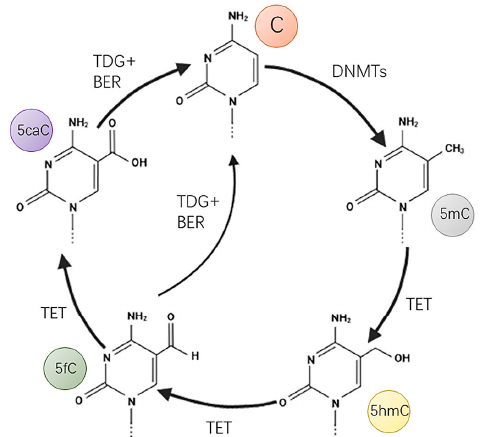
Figure 3. Mechanisms of DNA methylation and active demethylation. DNA methyltransferases (DNMTs) convert C to 5mC, which is progressively oxidized by TET to 5hmC, 5fC, and 5caC. 5fC and 5caC generate unmodified C through TDG ‐ and BER ‐ mediated excision and repair.